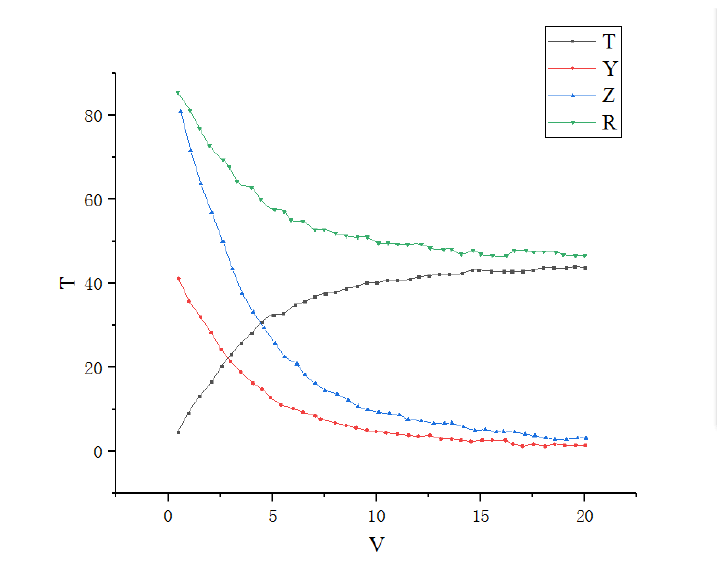
Fig. 1 Relationship between various angles and firing